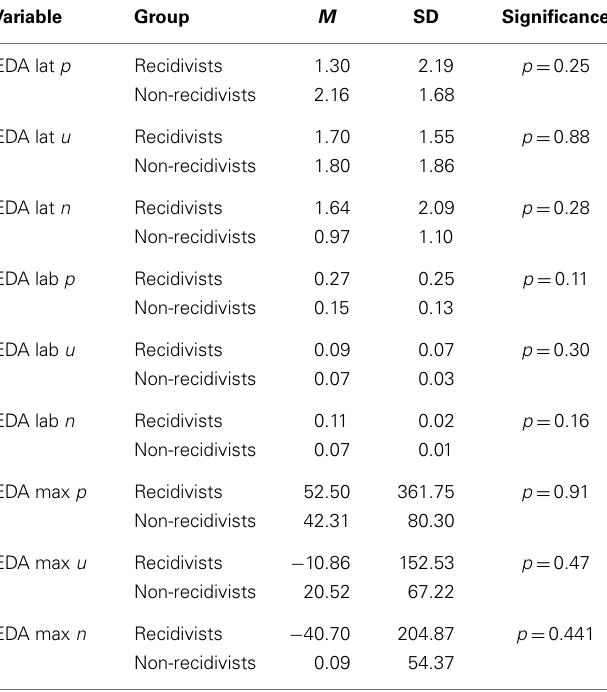
Table 4 | EDA measures in non-recidivist and recidivist juvenile offenders